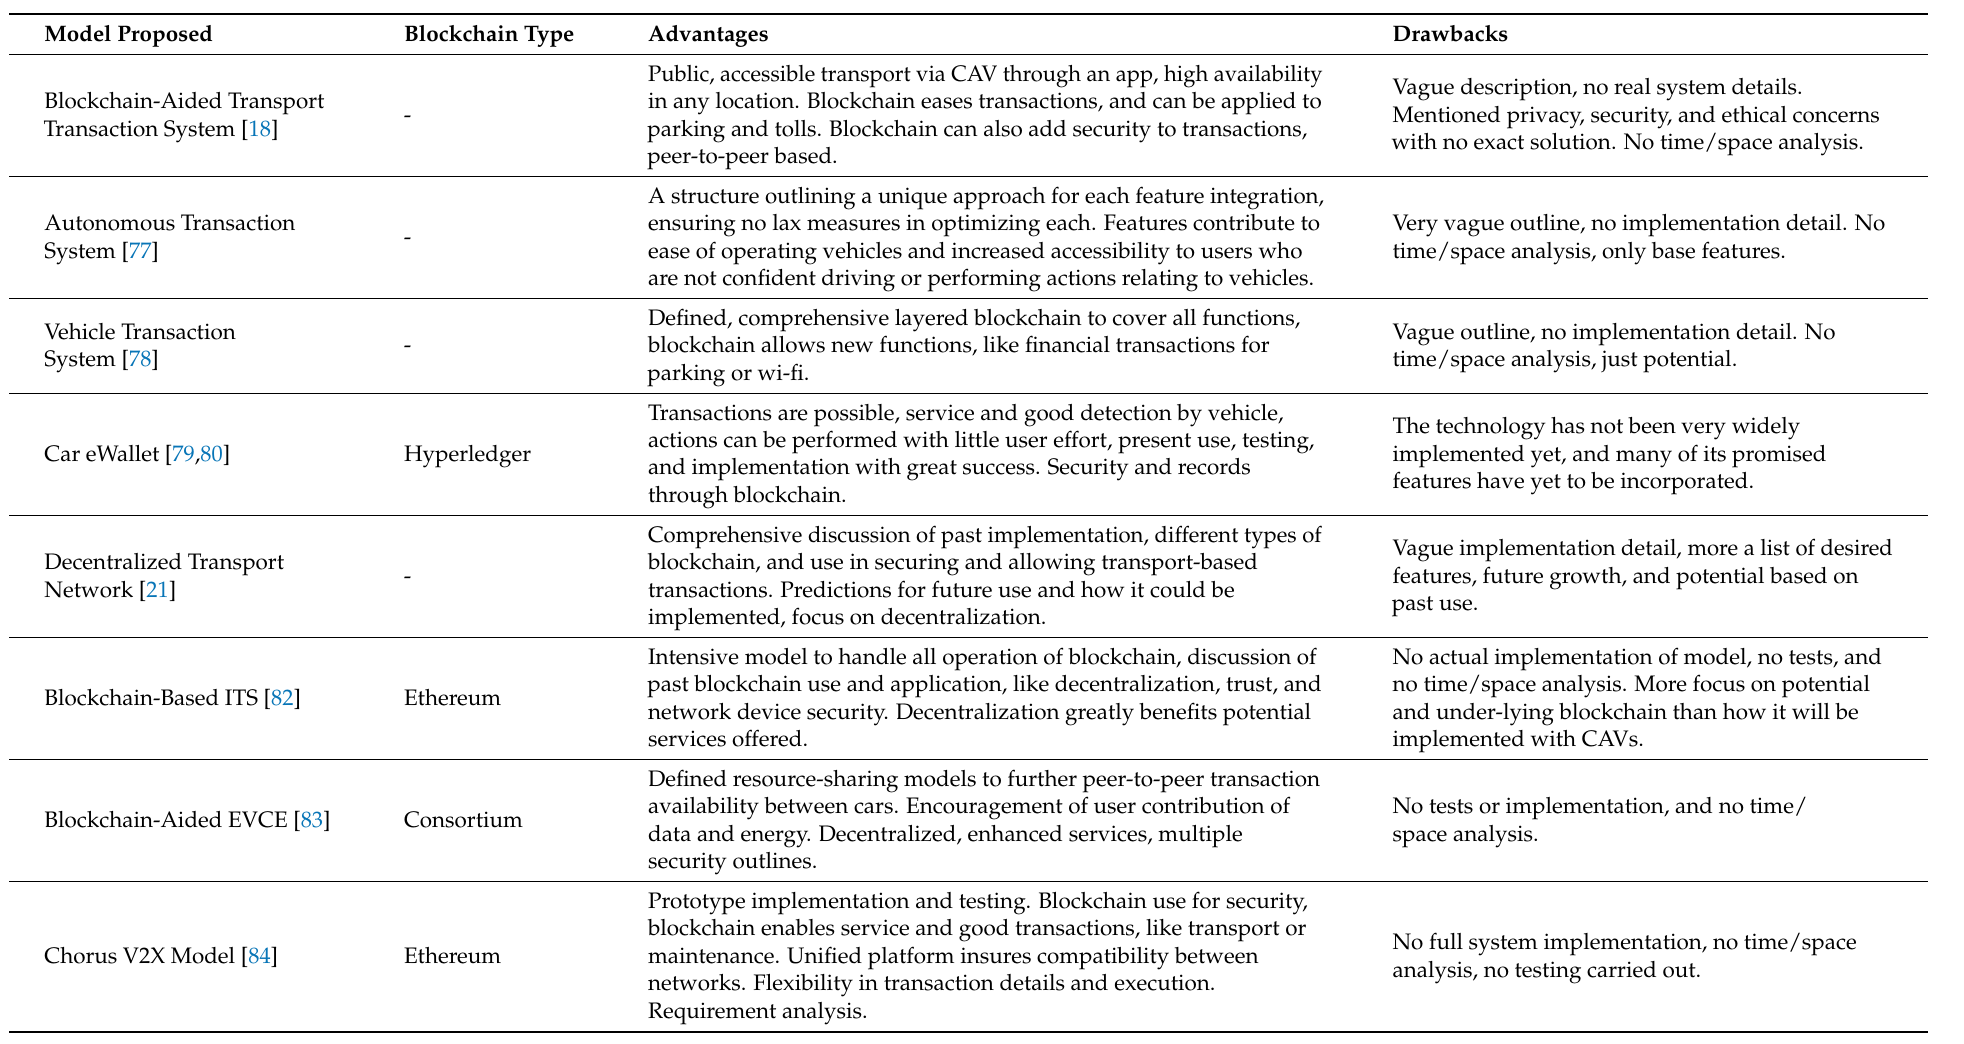
Table 4. Comparison of selected financial transaction methods in terms of advantages, drawbacks, and type of blockchain